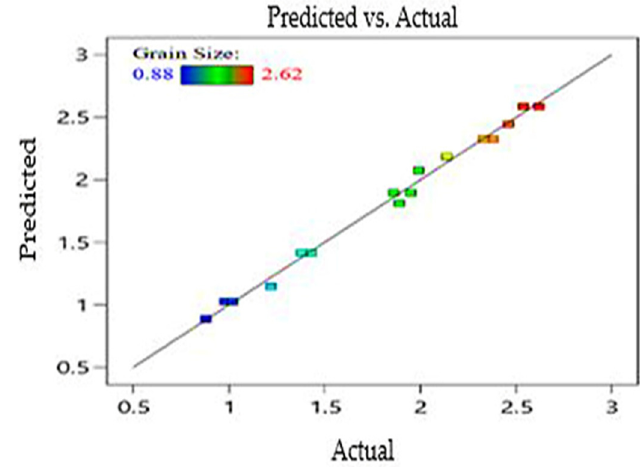
Figure 4. Predicted and actual value of ECAP responses G R .